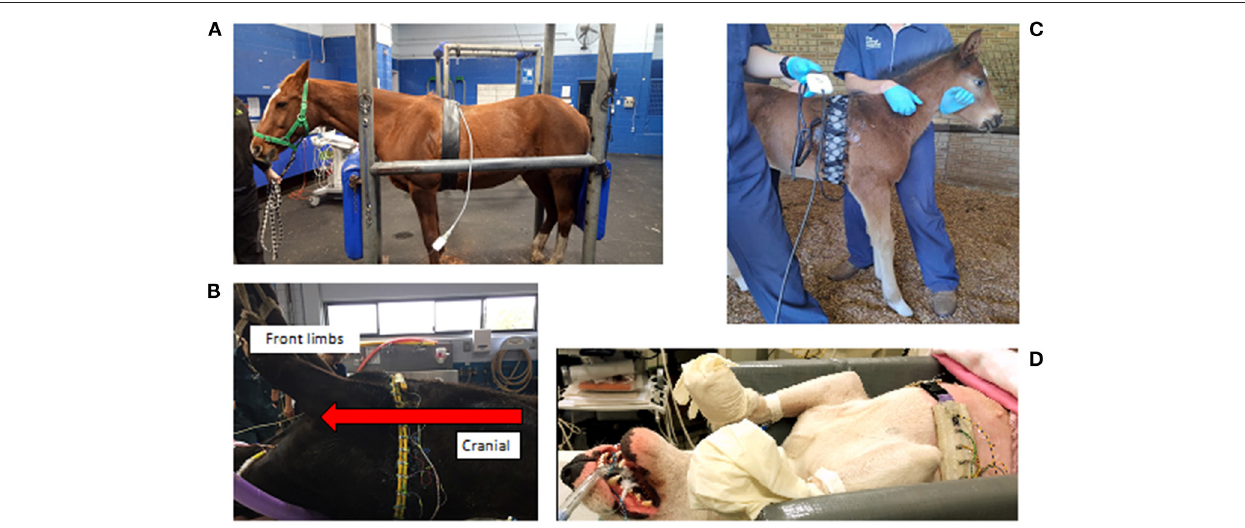
FIGURE 5 | Examples of various EIT belts available. (A) A single-plane horse belt made of neoprene fabric of 10cm width with integrated electrode and cable, positioned on a sedated horse in a standing position and connected to the data acquisition computer. (B) A single-plane cow belt made from two pieces of rubber tubing with individually wired electrodes and cables, positioned on an anaesthetised cow in dorsal recumbency with the cranial part of the cow to the left of the picture. (C) A single-plane foal belt made from elastic fabric of 10cm wide with push buttons and a detachable cable belt with integrated electrodes positioned on a